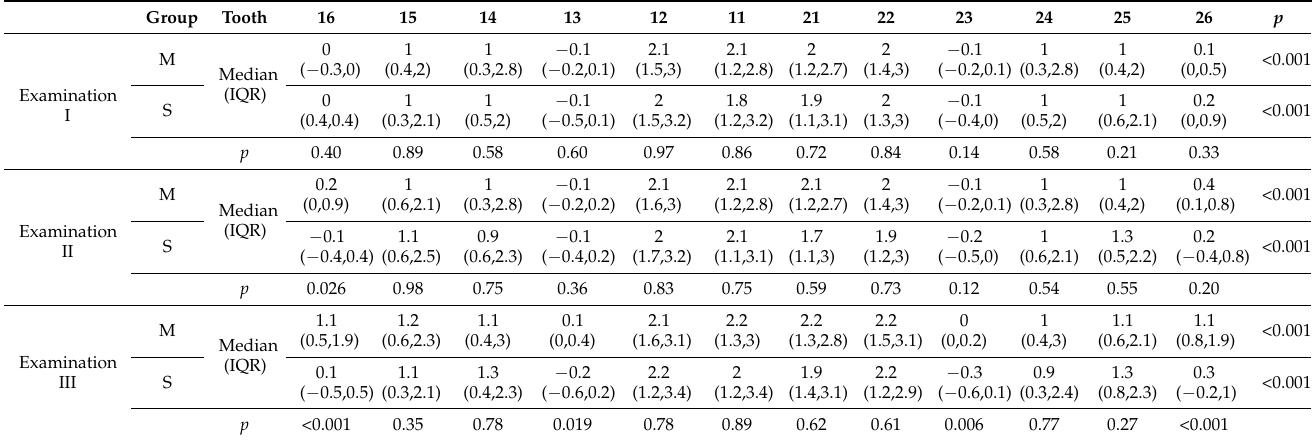
Table 2. Statistical analysis of the intra-group differences of PTV (obtained for the individual